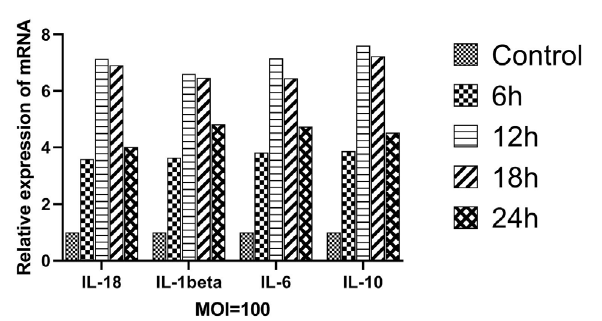
Fig. 3. Effect of S. suis 2 infection on the expression of cytokines (MOI = 100)